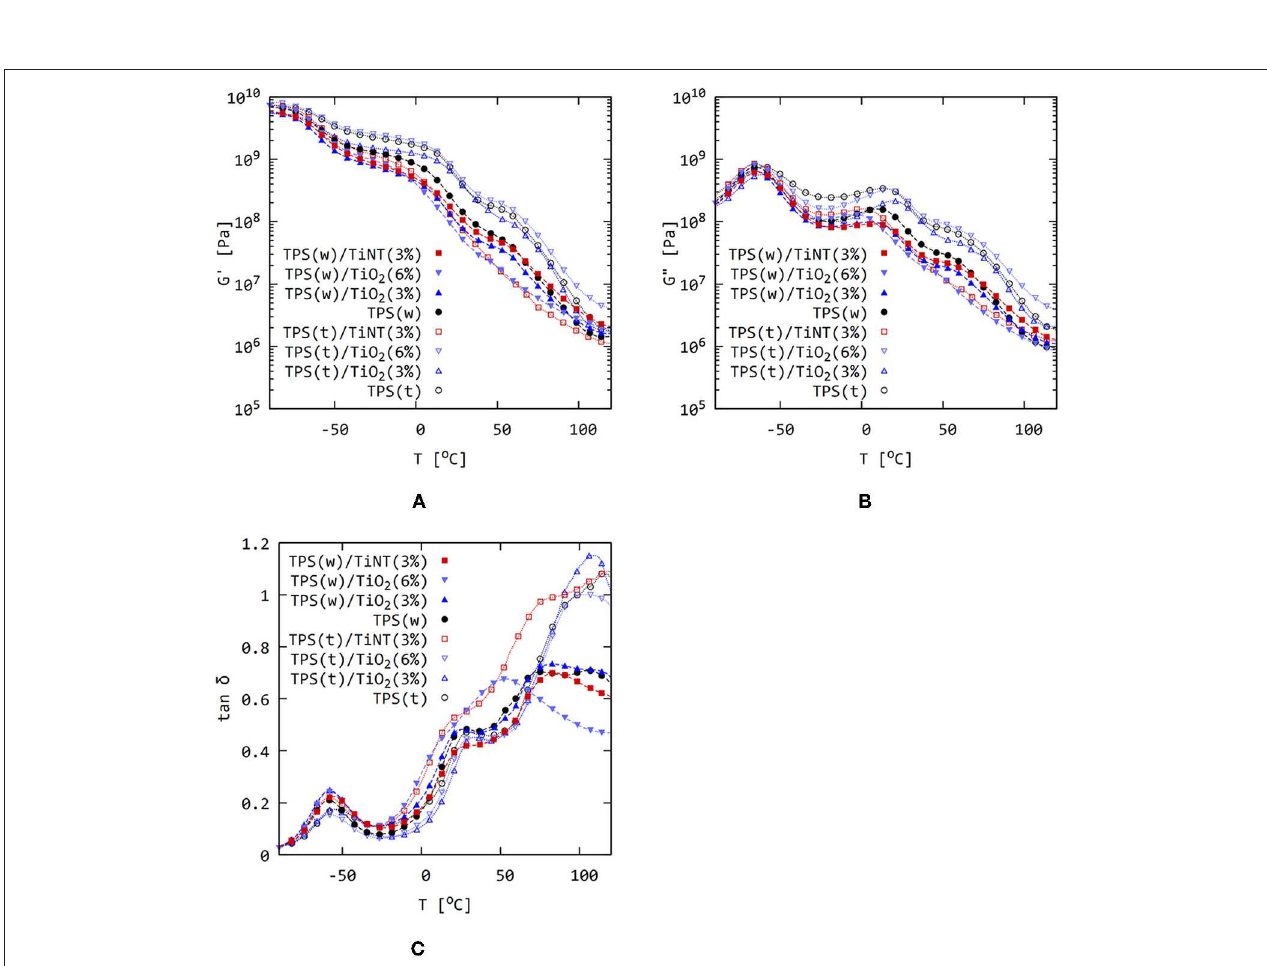
FIGURE 9 | Dynamic mechanical thermal analysis of wheat (w) and tapioca (t) TPS/TiX composites at angular frequency 1Hz and strain 0.05%: (A) storage modulus ( G ′ ), (B) loss modulus ( G ′′ ), and (C) damping factor [tan ( δ )].